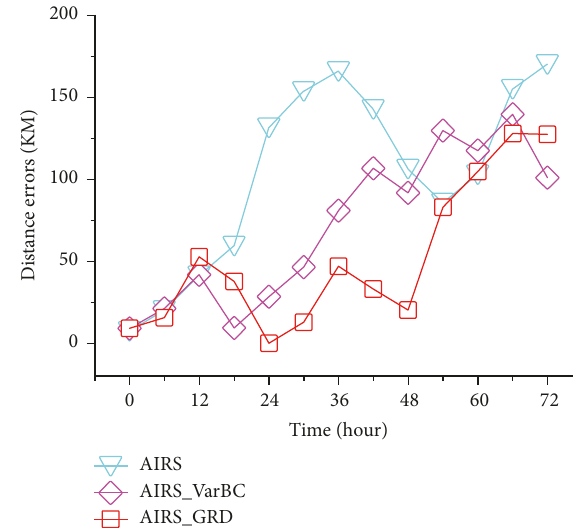
Figure 13: Track errors of the TC from experiments during the 72 h hindcast period.